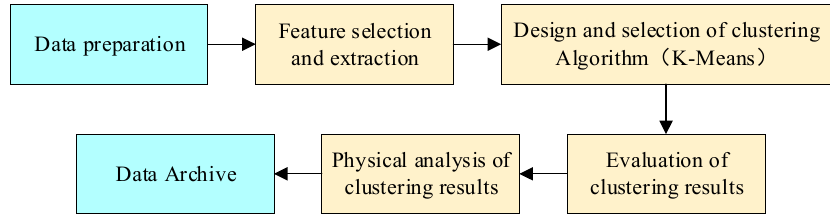
Figure 8. Clustering analysis process.